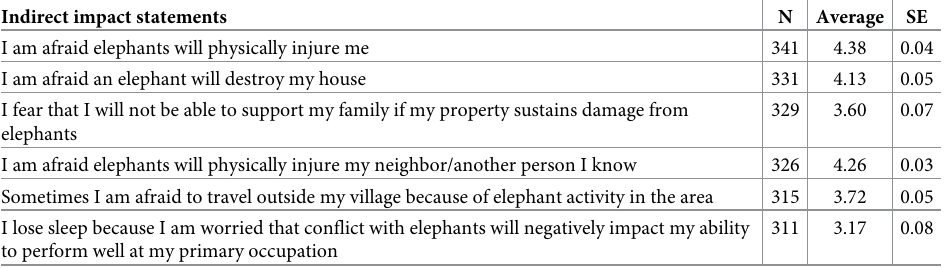
Table 4. Indirect impacts experienced by participants (n = 381) in the Bago-Yangon and Ayeyarwady regions of Myanmar (May 2017-December 2018). Indirect impact statements